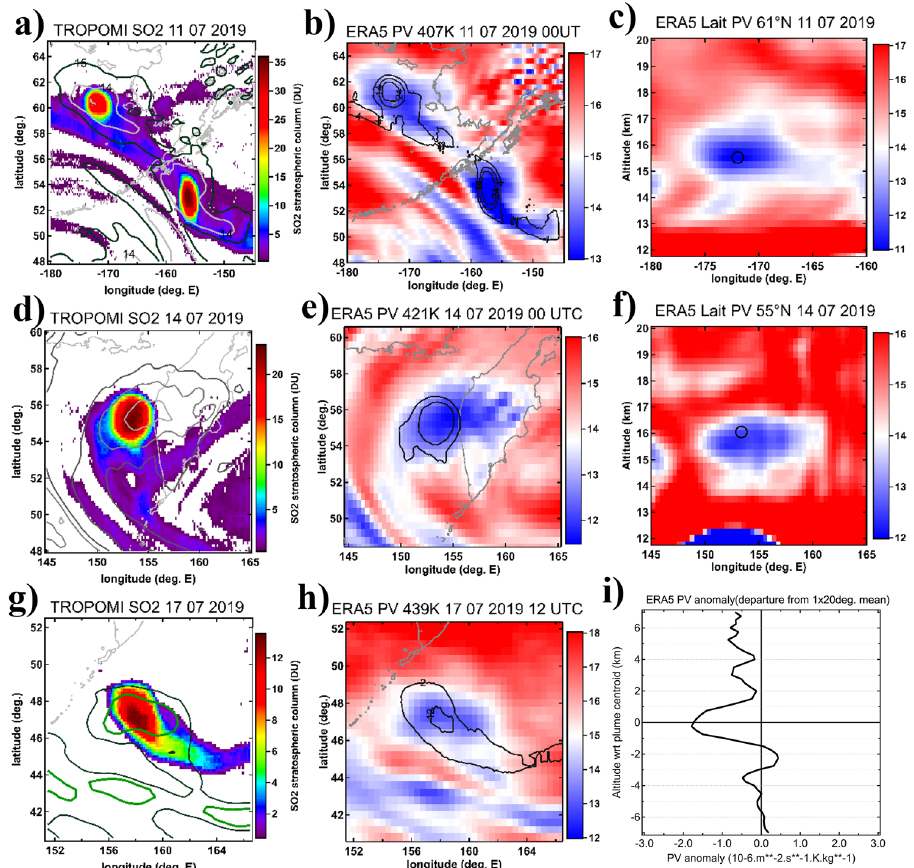
Figure 6. Potential vorticity of the vortex. (Left panels— a,d,g ) TROPOMI maps revealing isolated compact SO2 structure associated with the vortex on three different dates in July 2019. Contours indicate the corresponding low potential vorticity anomaly. (Middle panels— b,e,h ) ERA5 potential vorticity (PV in PVU, 1 PVU = 10 −6 Km 2 kg −1 s −1 ) interpolated to the potential temperature level of the aerosol plume centroid derived from satellite observations. Black contours mark the corresponding SO2 plume displayed in the left panels. (Right panels— c,f ) Longitude-altitude sections of ERA5 Lait PV at the latitude of the primary VVP. The black circle marks the corresponding aerosol plume location derived from satellite observations. ( i ) Composited PV anomaly altitude profile with respect to the aerosol plume centroid obtained from ERA5 data between 25 July and 10 August. The PV anomaly is obtained as a deviation from an average PV profile within 1° latitude × 20° longitude